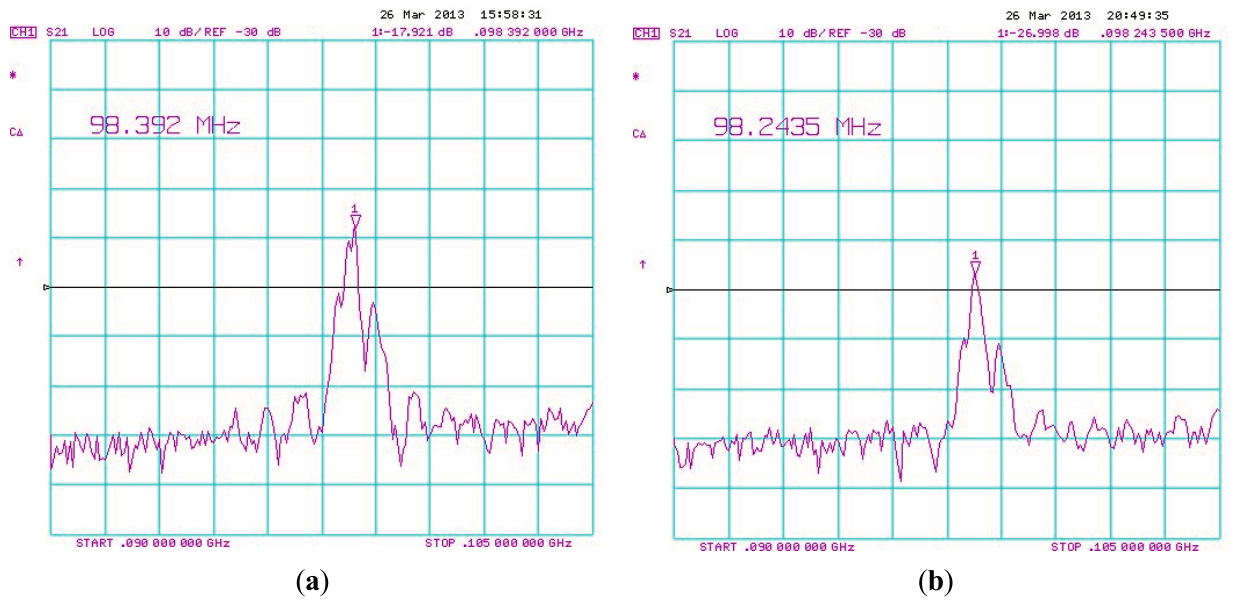
Figure 3. Example of frequency responses of ( a ) a raw SAW resonator and ( b ) after Cu 2+ /PANI/WO 3 layer